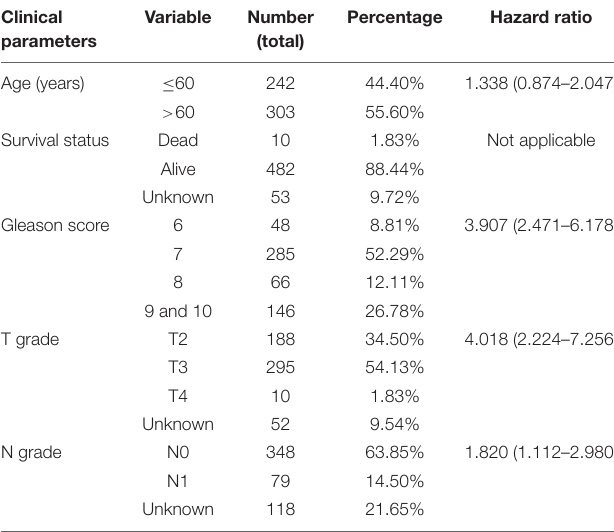
TABLE 1 | Clinical information from the 545 PCa patients of